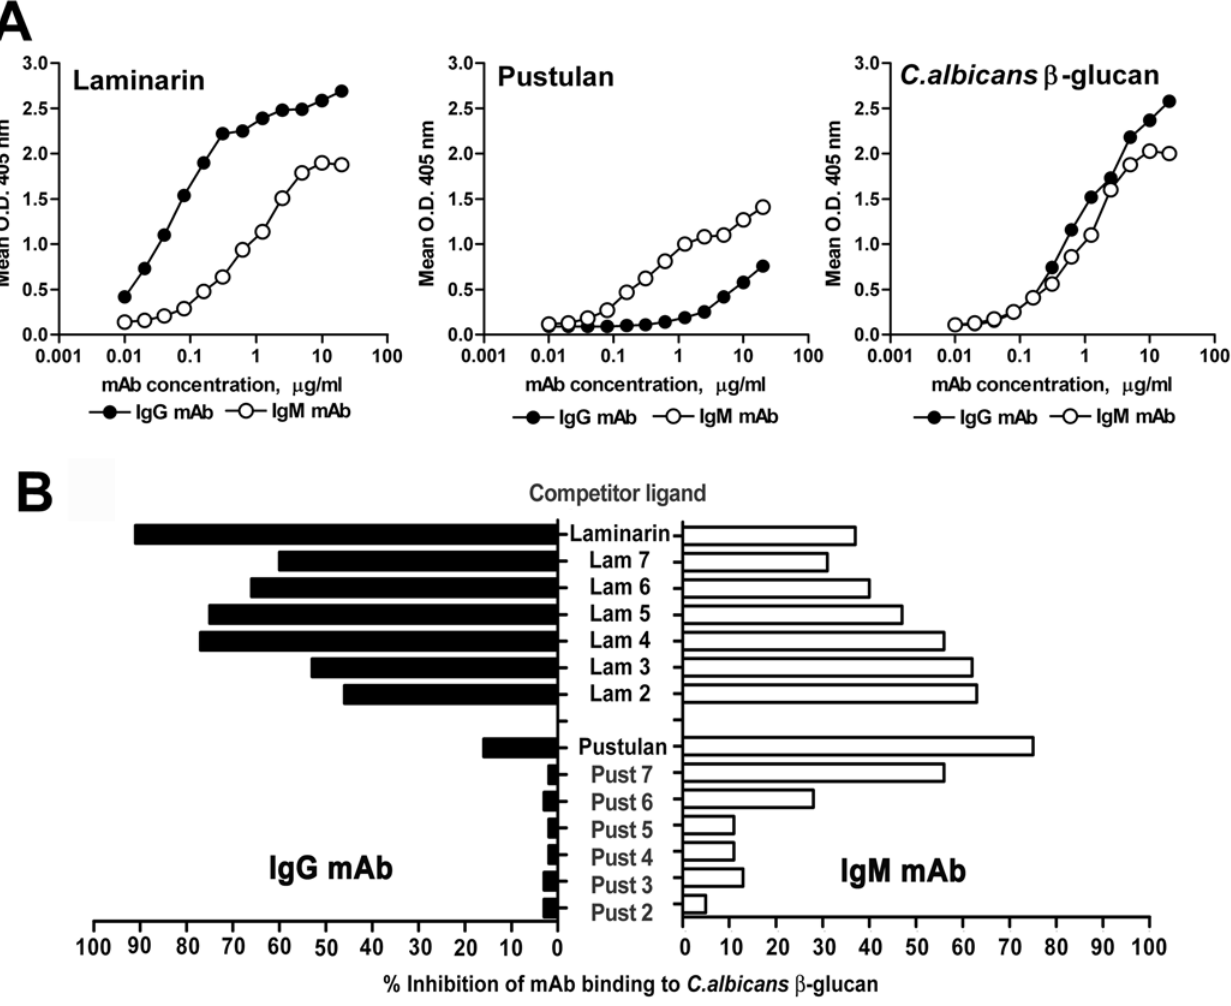
Figure 3. Reactivity of the anti b -glucan mAbs to b -glucans of different molecular structure. Panels A: dose-effect, ELISA mAb binding curves to plastic-adsorbed laminarin ( b 1,3 glucan), pustulan (linear b 1,6 glucan) and C. albicans b -glucan (mixed, highly branched b 1,3/ b 1,6-glucan). The graph illustrates the outcome in a typical experiment out of five performed with similar results. Binding is expressed as mean O.D. 405 nm readings from triplicate wells after subtraction of O.D. from the negative controls (wells reacted with no mAb or with an irrelevant mAb). SEM values were always , 15% and are not shown. Panel B: ELISA competition assays. Laminarin, pustulan and two series of b 1,3 or b 1,6 oligosaccharides of DP 2 to 7 (Lam or Pust 2 trough 7, respectively) were tested for ability to inhibit the binding of the mAbs to plastic-adsorbed, C. albicans b -glucan. Competitive binding activity is expressed as percent reduction of mAb O.D. 405 nm readings in the presence of the various competitor ligands, as compared to O.D. readings in the absence of competitors. Data in the figure are those from one representative experiment, out of three performed with similar results, using the mAbs at 1 m g/ml and 10 m g/ml and 50 m g/ml of b 1,3- and b 1,6-linked saccharide competitors, respectively.